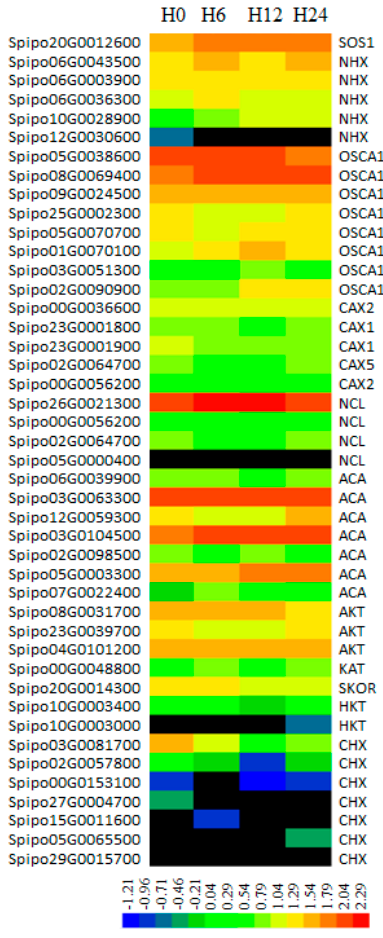
Figure 7. Expression pattern of cation transporters . The accession numbers are provided on the left column, and the gene identities are provided on the right column. The FPKM values of each gene at 0, 6, 12, and 24 h after 100 mM NaCl treatment, respectively, were transformed by 10-based logarithm and are presented in color as scaled by the color bar.